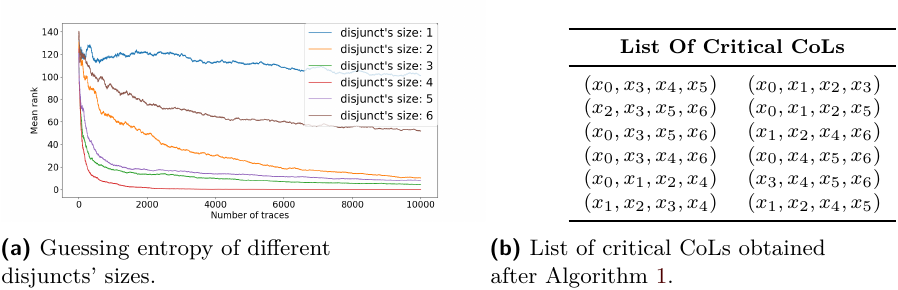
Figure 11: Guessing entropy of step 1 and the list obtained after Algorithm 1 for TTSCA big on ASCADv1_f.